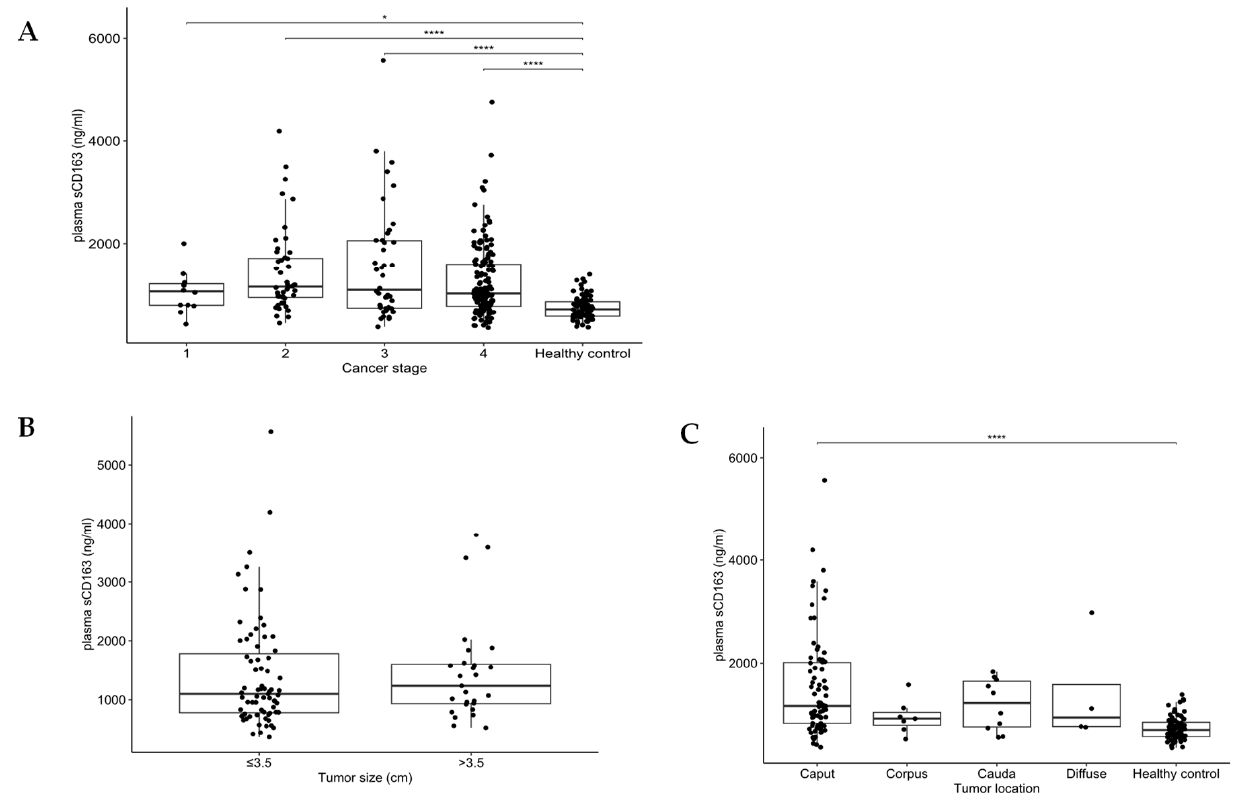
Figure 1. Box plot showing the distribution of sCD163 concentrations in patients with pancreatic ductal adenocarcinoma at time of diagnosis stratified by stage, and in healthy controls ( A ), by tumor size in resected patients ( B ), and by tumor location in resected patients ( C ). * = p value = 0.033; **** = p value = <0.0001.